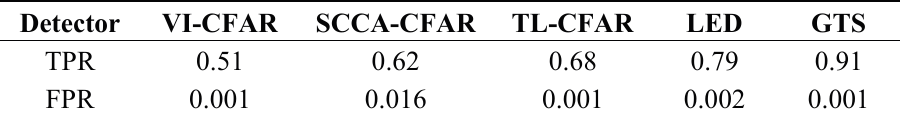
Figure 14. Results of different detector in multi-targets case. ( a ) is the original SAR image; ( b ) is the result of VI-CFAR detector; ( c ) is the result of SCCA-CFAR detector; ( d ) is the result of TL-CFAR detector; ( e ) is the result of LED detector; ( f ) is the result of GTS detector. The regions labeled by green rectangles in ( a ) are the aircraft targets in the SAR image ( a ). Table 1. Detection Results on Test